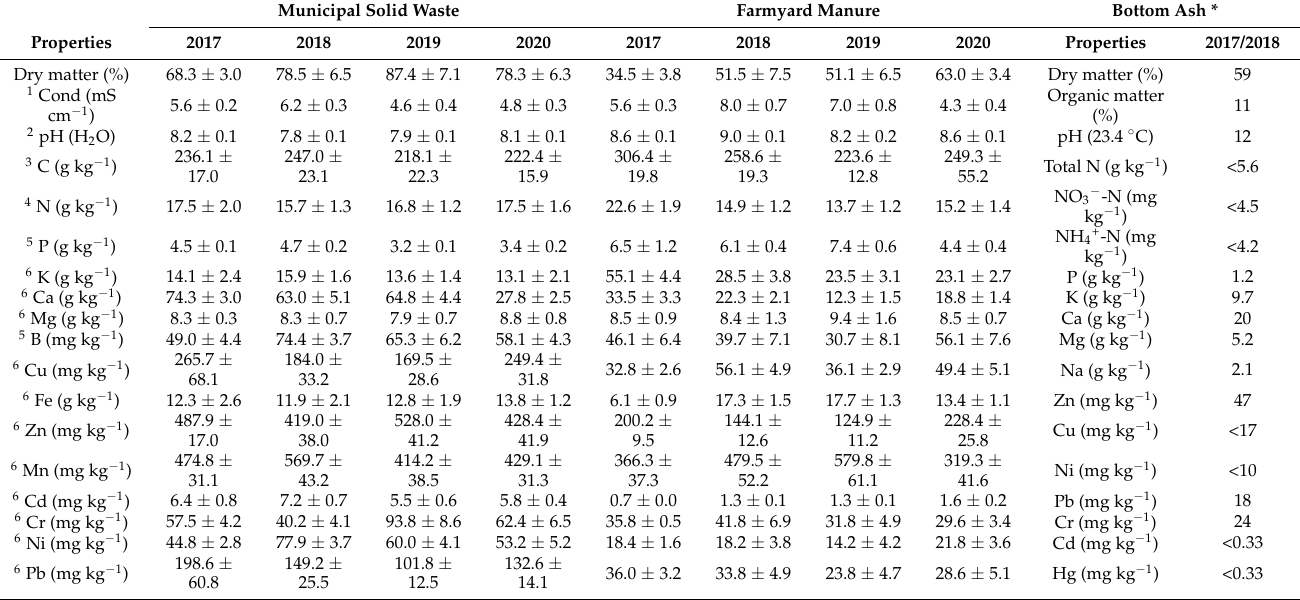
Table 2. Properties (average ± standard deviation) of soil amendments used in the field